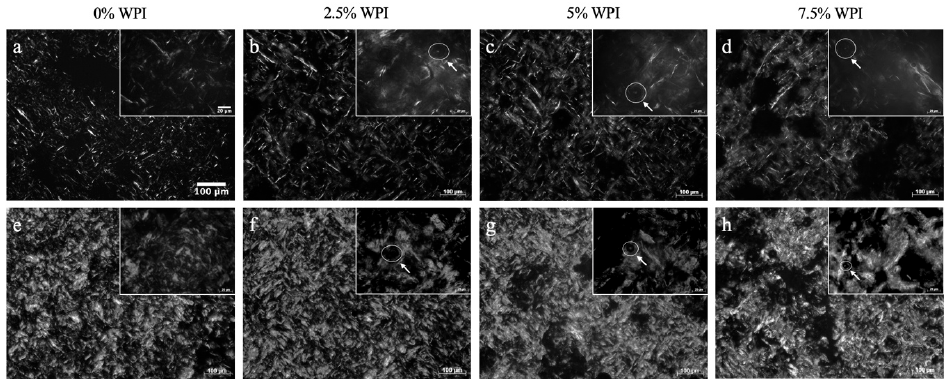
Figure 9. PLM images of: ( a ) OG gelled with 1% RBW, ( b – d ) OC samples gelled with 1% RBW, ( e ) OG gelled with 10% RBW, and ( f – h ) OC samples gelled with 10% RBW.